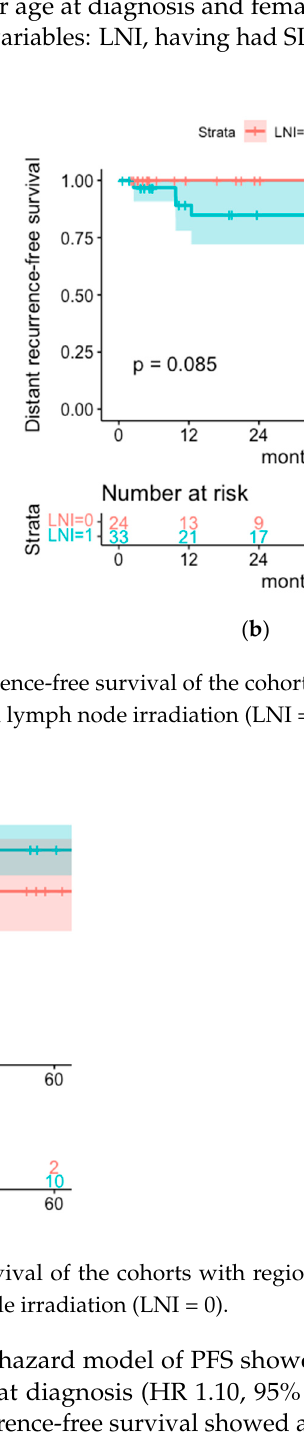
Figure 5. Regional recurrence-free survival of the cohorts with regional lymph node irradiation (LNI = 1) or without regional lymph node irradiation (LNI = 0).